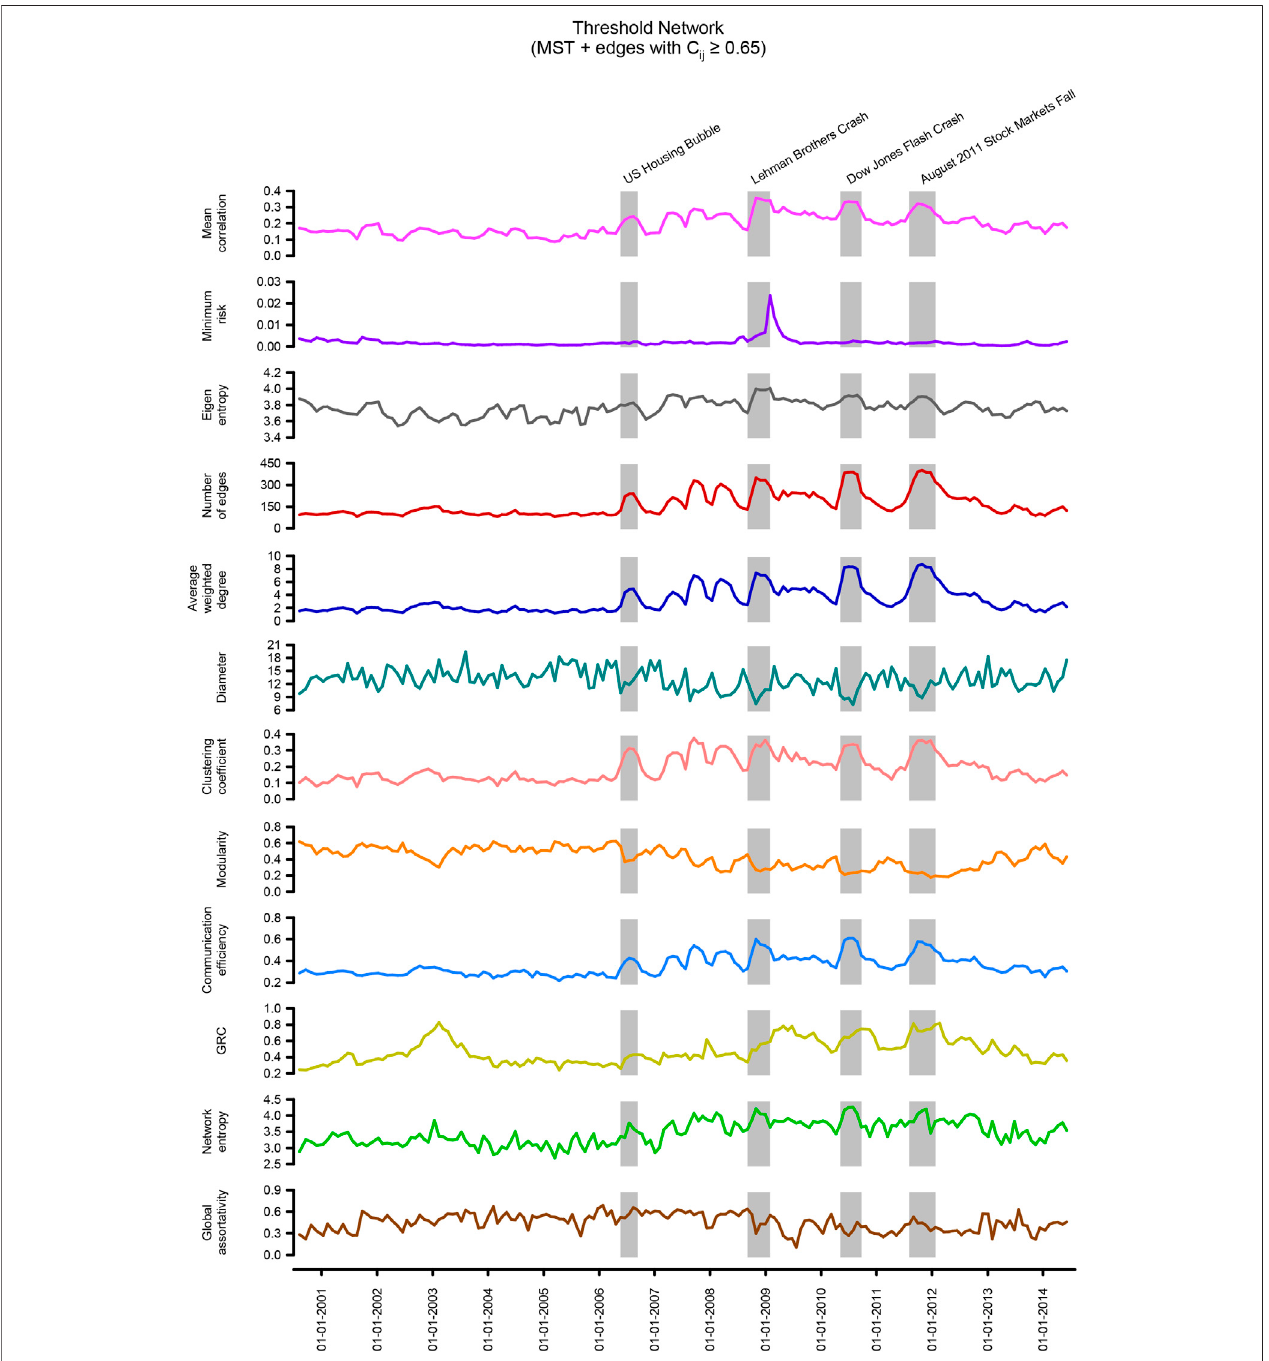
FIGURE 1 | Evolution of generic indicators and network characteristics for the global market indices networks S τ ( t ), constructed from the correlation matrices C τ ( t ) of window size τ (cid:1) 80 days and an overlapping shift of Δ τ (cid:1) 20 days over a period of 14 years (2000 – 2014). The threshold networks S τ ( t ) were constructed by adding edges with correlation C τ ij ( t ) ≥ 0 . 65 to the minimum spanning trees (MST). From top to bottom, we compare the plots of mean correlation among market indices, minimum risk corresponding to the Markowitz portfolio optimization, eigenentropy, number of edges, average weighted degree, diameter, clustering coef fi cient, modularity, communication ef fi ciency, global reaching centrality (GRC), network entropy, and global assortativity. The four shaded regions correspond to the epochs around the four important market events, namely, US housing bubble, Lehman brothers crash, Dow Jones fl ash crash, and August 2011 stock markets